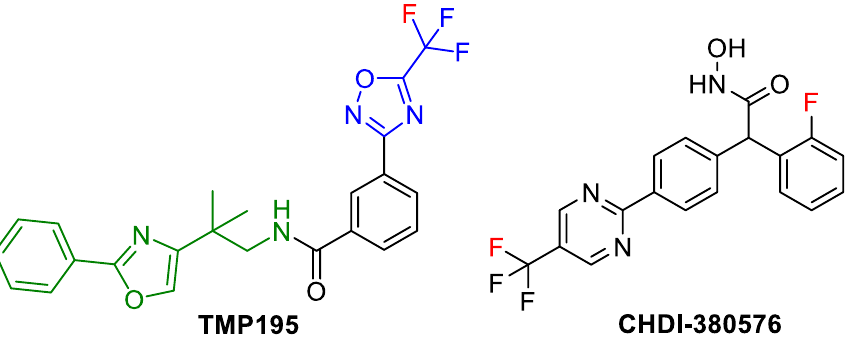
Figure 1. Reported highly potent inhibitors of class-IIa HDACs 31,34